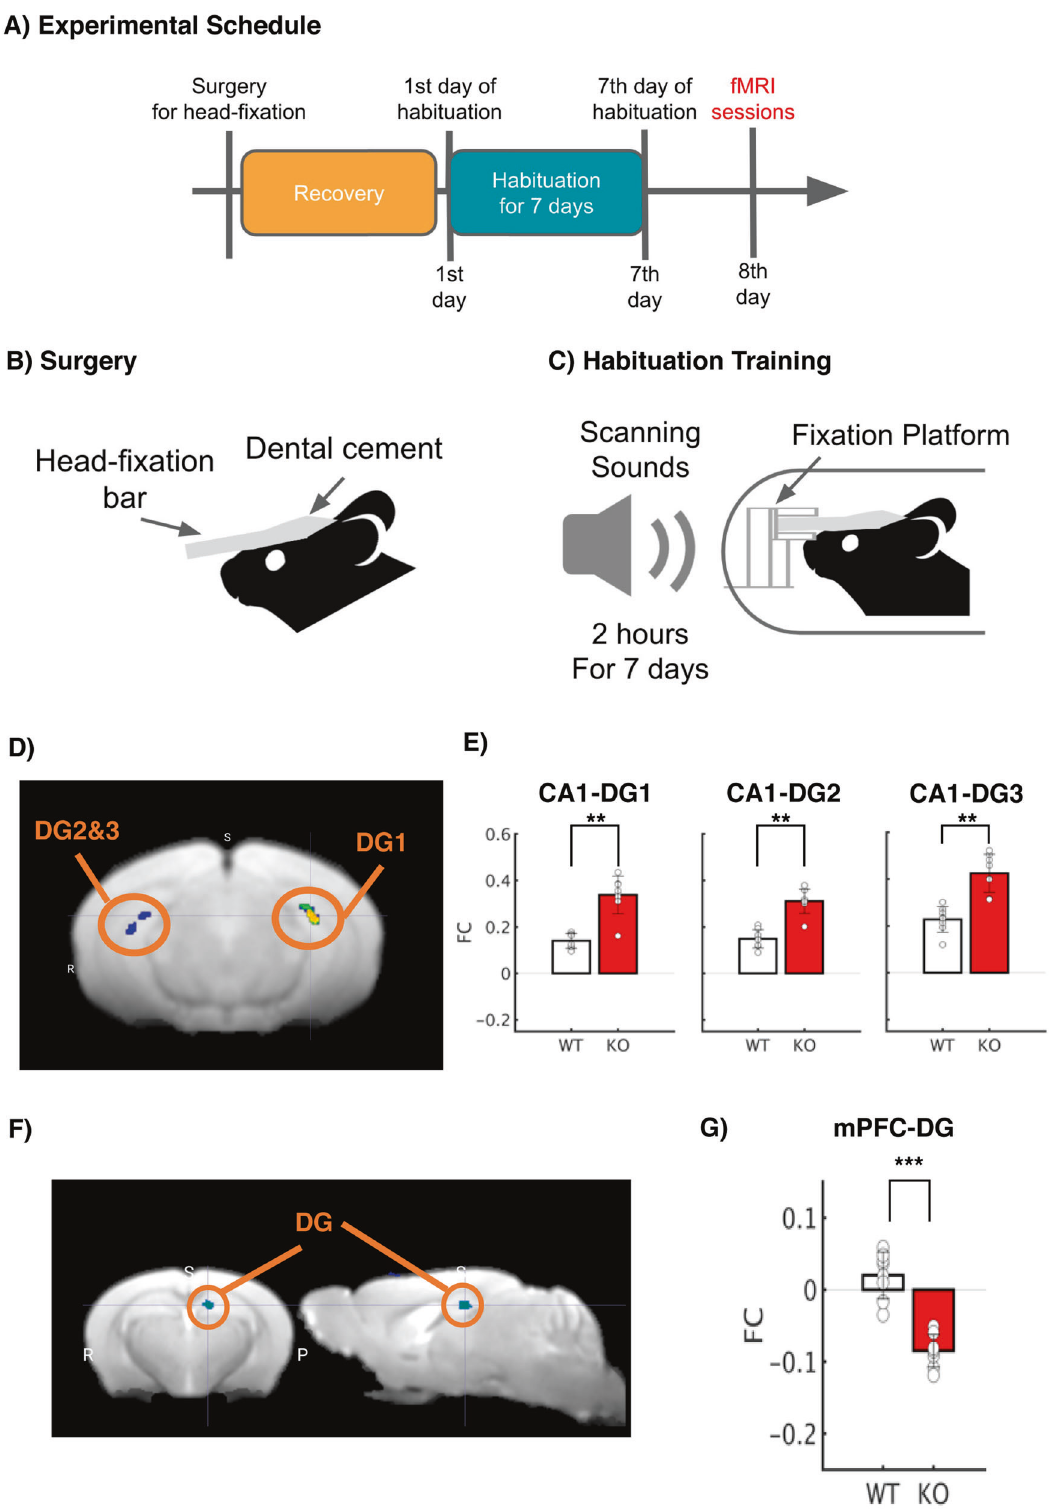
No stress vs 1 h p = 0.0221) 1 h after mice were introduced to inescapable electric shock stress (Fig. 1D). ERK phosphorylation levels also increased after acute stress, concurrently with TOB expression. Thus, TOB is expressed in the mouse brain and its expression is increased following acute